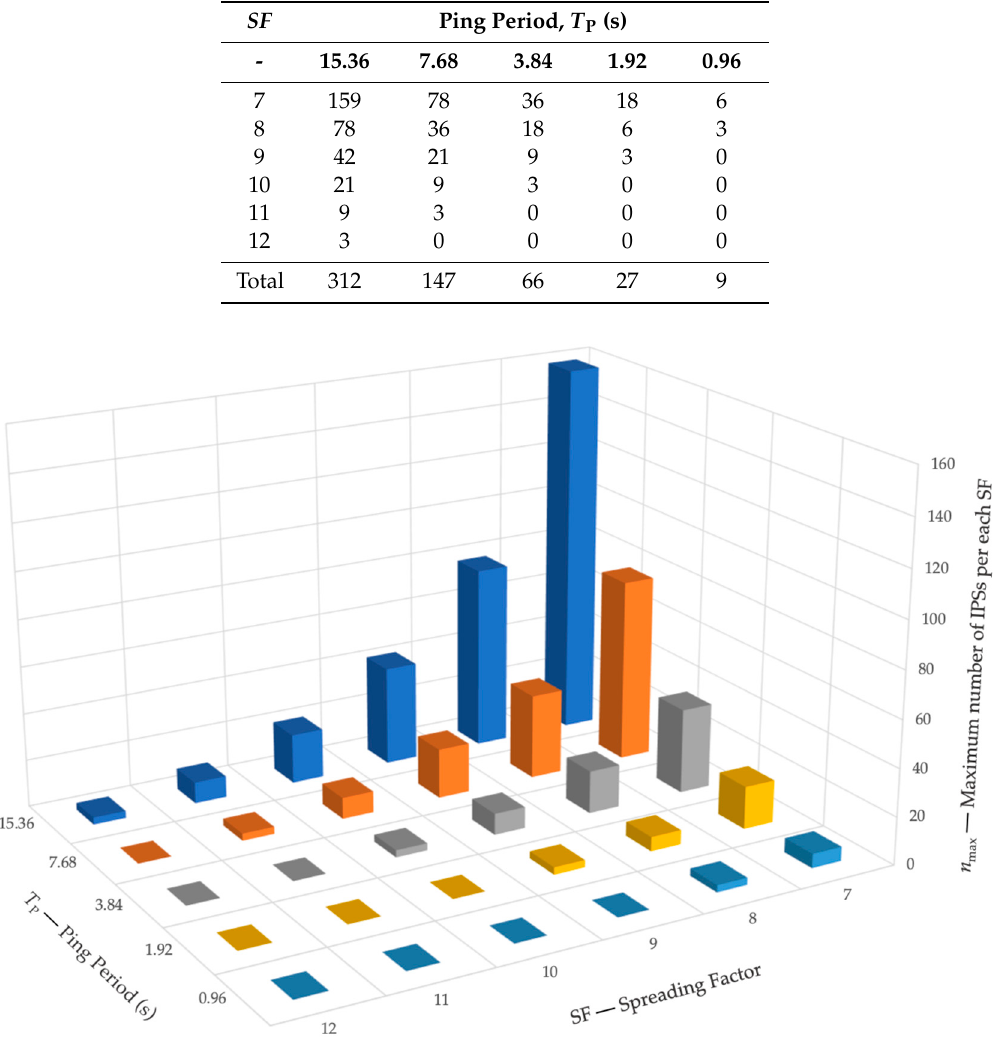
Figure 11. Maximum number of coordinated IPSs for each SF (considering the use of all the three compulsory LoRaWAN channels) depending on the selected ping period, in the scenario with up to 312 mapped devices. SF : Spreading Factor. Table 8. Maximum expected response time for each SF depending on the selected ping period, in the scenario with up to 312 mapped devices. SF : Spreading